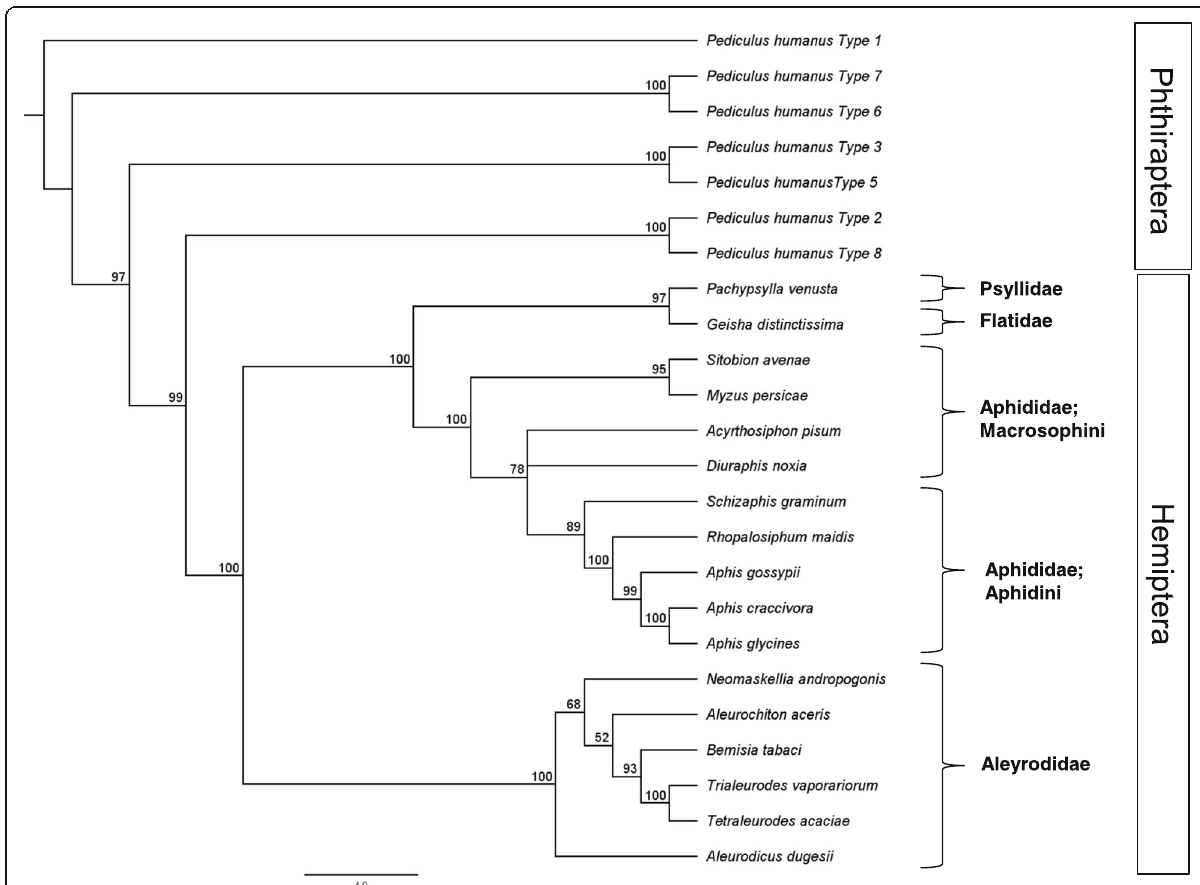
Fig. 2 PAUP generated phylogenetic tree based on whole mitochondrial genomes. A maximum parsimony tree generated through PAUP [56] utilizing whole mitochondrial genomes, that was aligned with MAFFT [57], illustrating Diuraphis noxia ’ s close association with Acyrthosiphon pisum